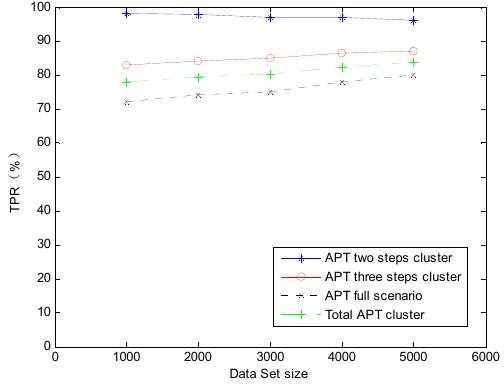
Figure 10. The TPR varies with data set size changes.